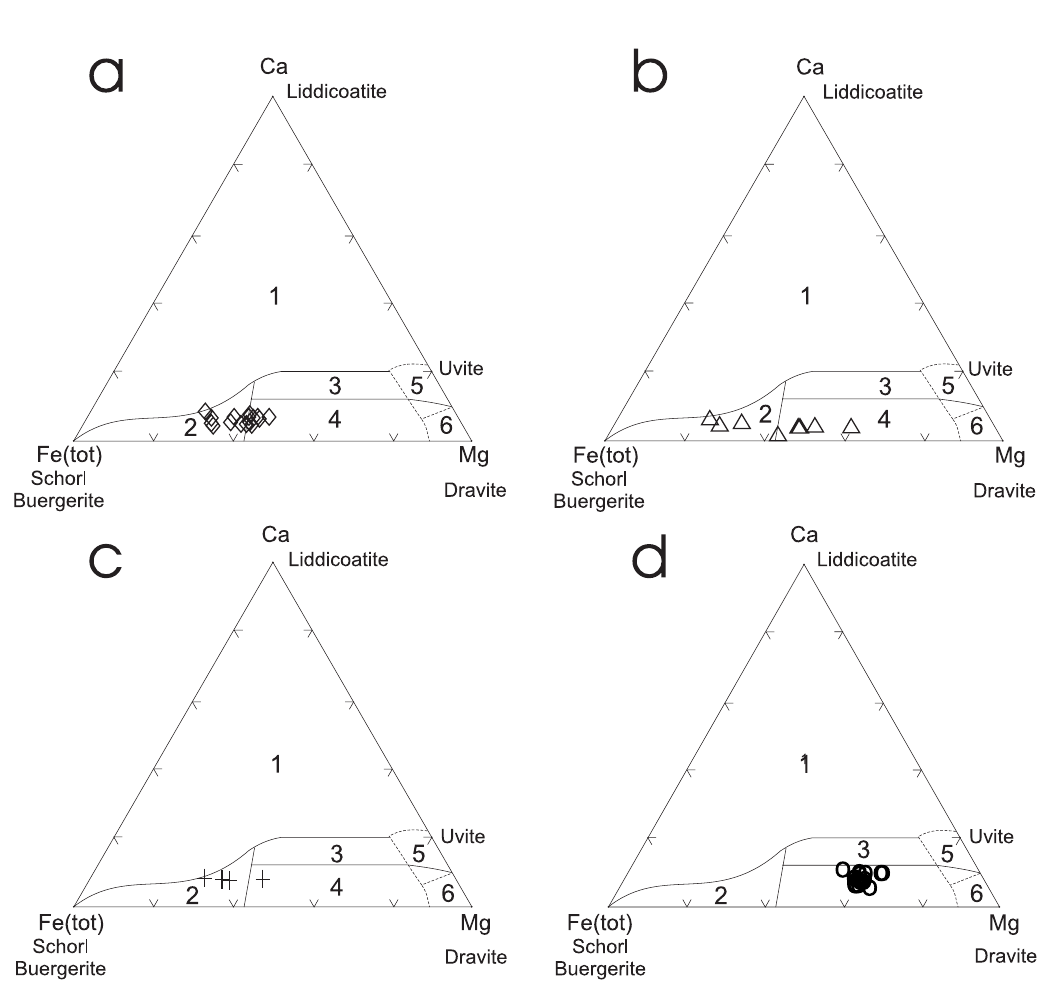
Fig. 4 – Representation of tourmaline compositions in Henry and Guidotti’s (1985) Ca-Fe tot -Mg diagram (molecular proportions). Tourmalines from: (a) metachert – Tapera Grande and Quartzito; (b) tourmalinite – Tapera Grande; (c) quartz vein – Tapera Grande, and (d) quartz vein – Quartzito. Fields: (1) Li-rich granitoid pegmatites and aplites; (2) Li-poor granitoids and their associated pegmatites and aplites; (3) Ca-rich metapelites, metapsammites, and calc- silicate rocks; (4) Ca-poor metapelites, metapsammites, and quartz-tourmaline rocks; (5) metacarbonates, and (6)